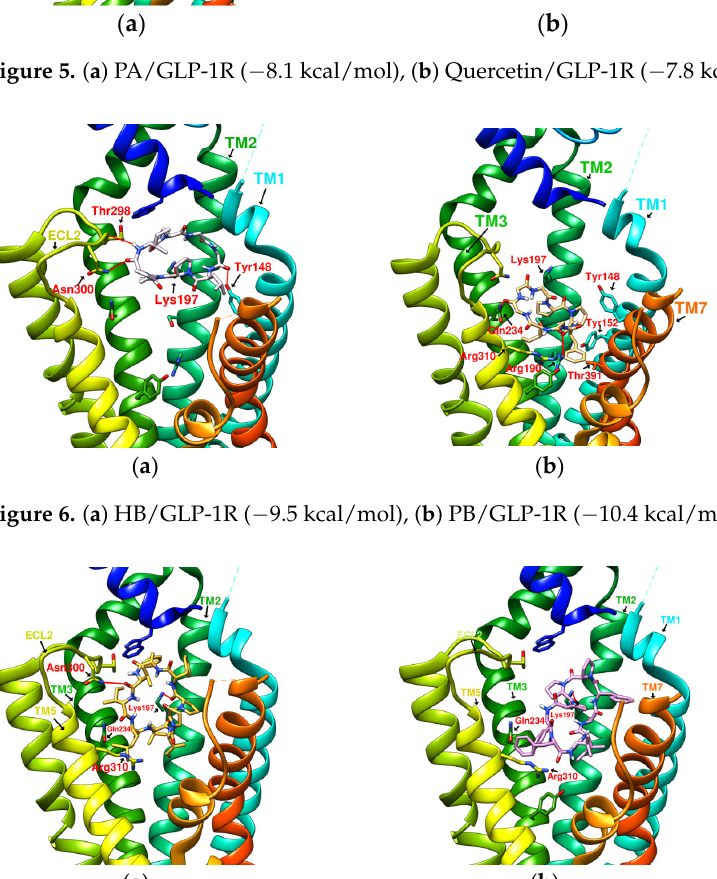
Figure 7. ( a ) CLC/GLP-1R (−10.6 kcal/mol), ( b ) DmA/GLP-1R (−11.2 kcal/mol).